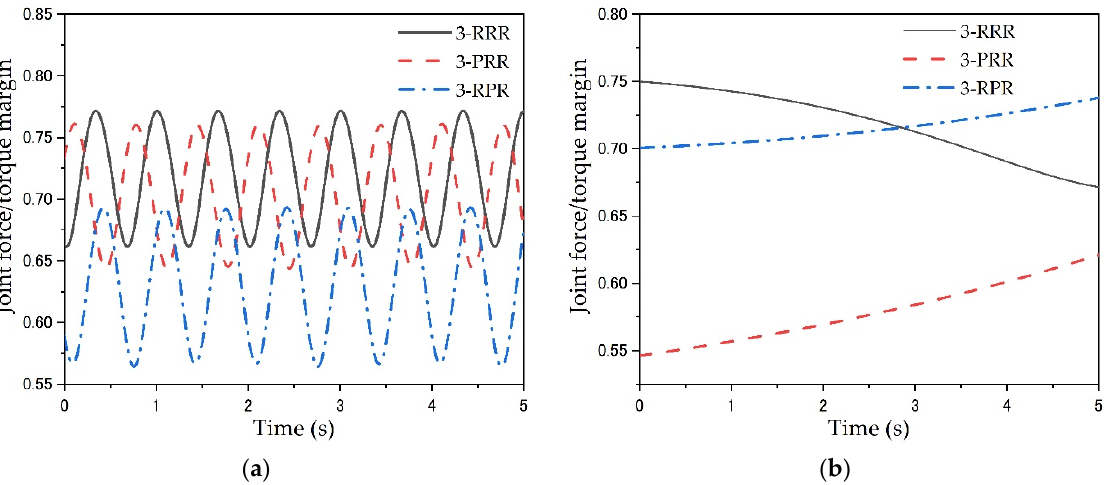
Figure 17. Comparison of the joint force/torque margin of the three PPMs: ( a ) under a circular trajectory; ( b ) under a linear trajectory.